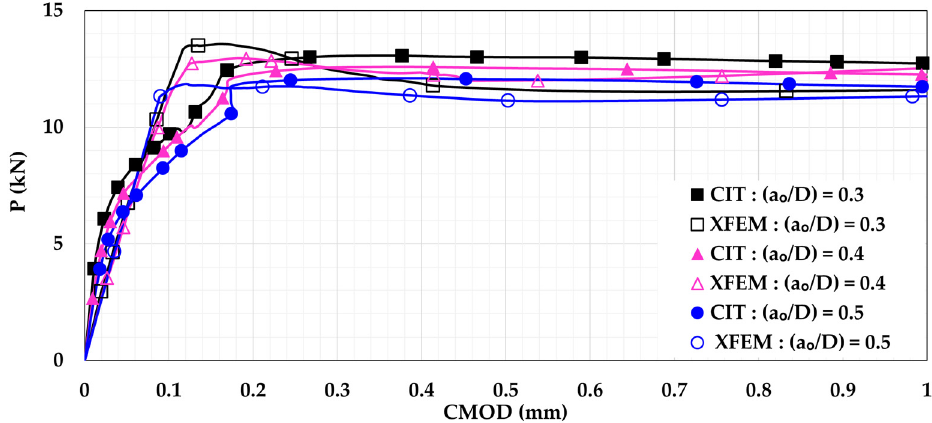
Figure 7. Reinforced concrete beam P-CMOD relationships for different initial notch-to-depth ratios (a o /D).